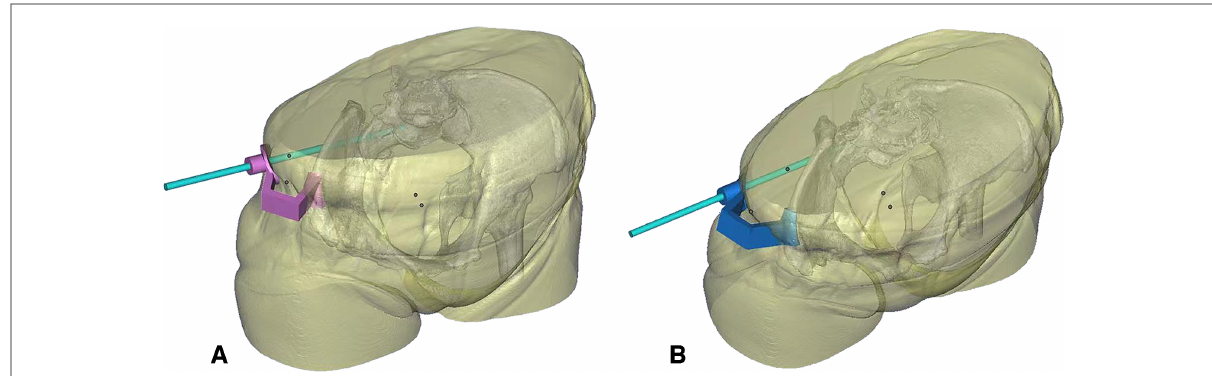
FIGURE 3 3D printing model of this case. ( A ) The anchoring surface is used to fi x the template next to the anterior superior iliac spine. ( B ) The bridging rod is a connection between the anchoring surface and the positioning hole outside the body. The positioning hole is used for percutaneous insertion of the guidewire.